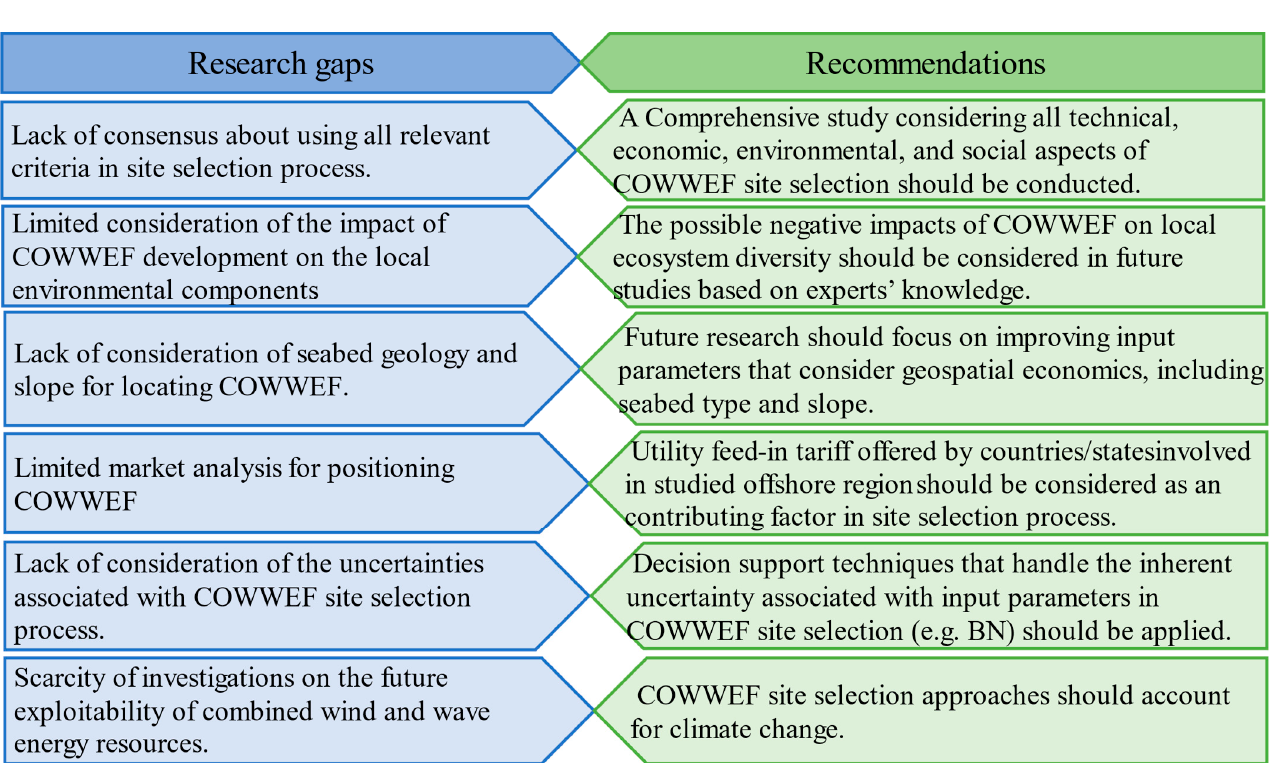
Figure 6. A summary of research gaps and recommendations for future studies.